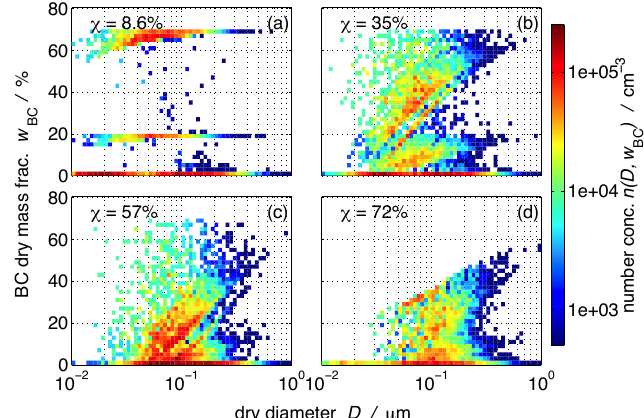
Figure 1. Number concentration in two-dimensional space of dry diameter and black carbon mass fraction, n ( D , w BC ) , for four example populations that differ in mixing state index χ